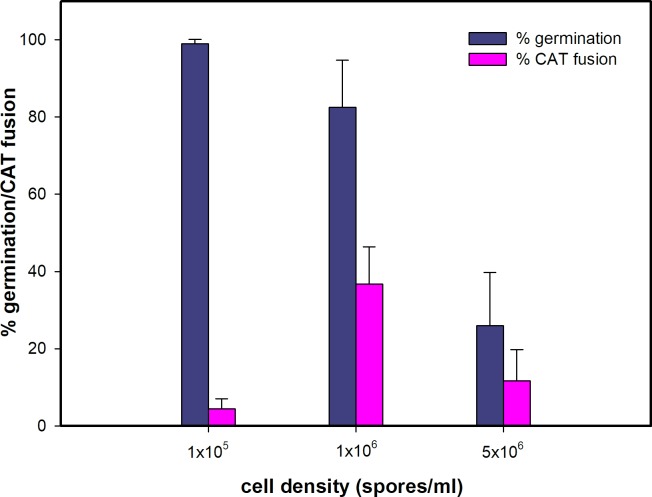
Effect of microconidial density on germination and CAT fusion in 1% PDB + 25 mM NaNO3.1 x 106 spores/ml provided optimal CAT fusion.